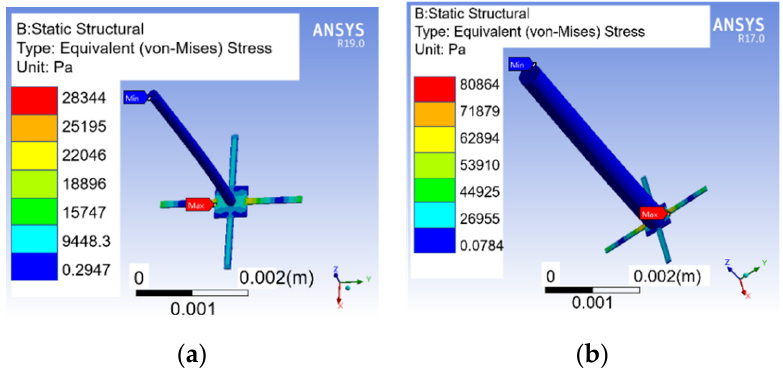
Figure 8. Stress distribution on cantilever beams. ( a ) The previous microstructure; ( b ) the improved cilium microstructure.